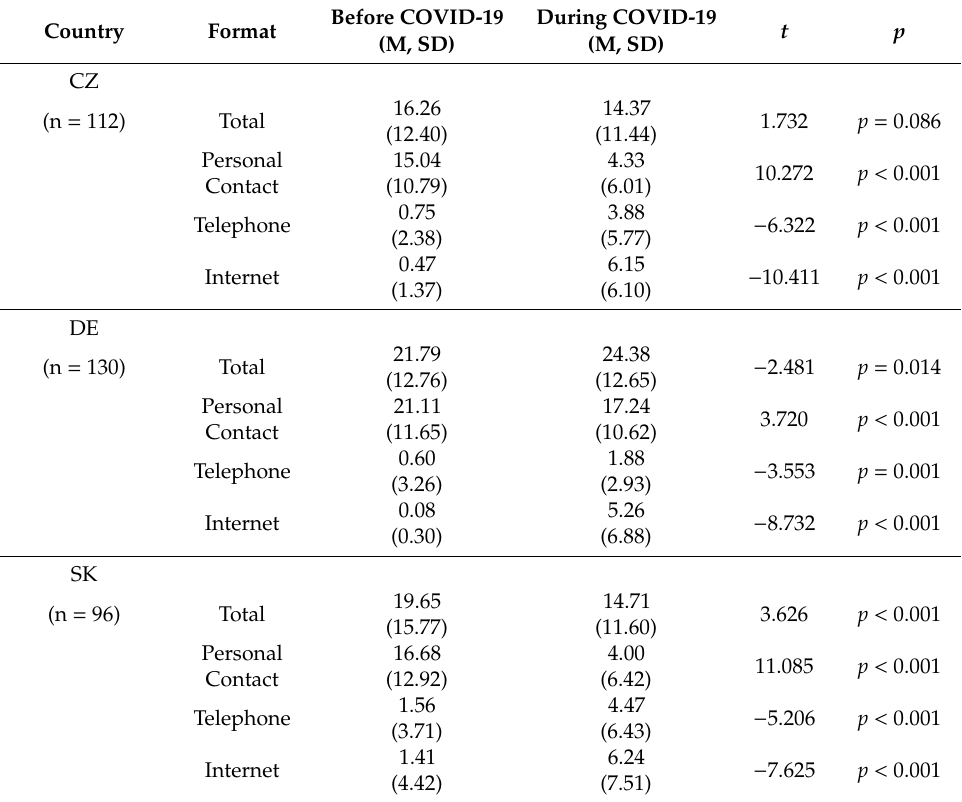
Table 3. Number of patients treated on average per week before and during COVID-19 in the Czech Republic (CZ), Germany (DE) and Slovakia